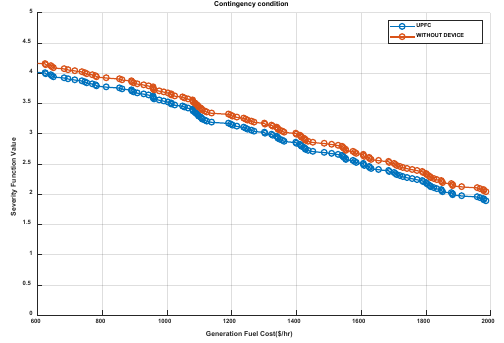
Figure 19. Analysis of severity index